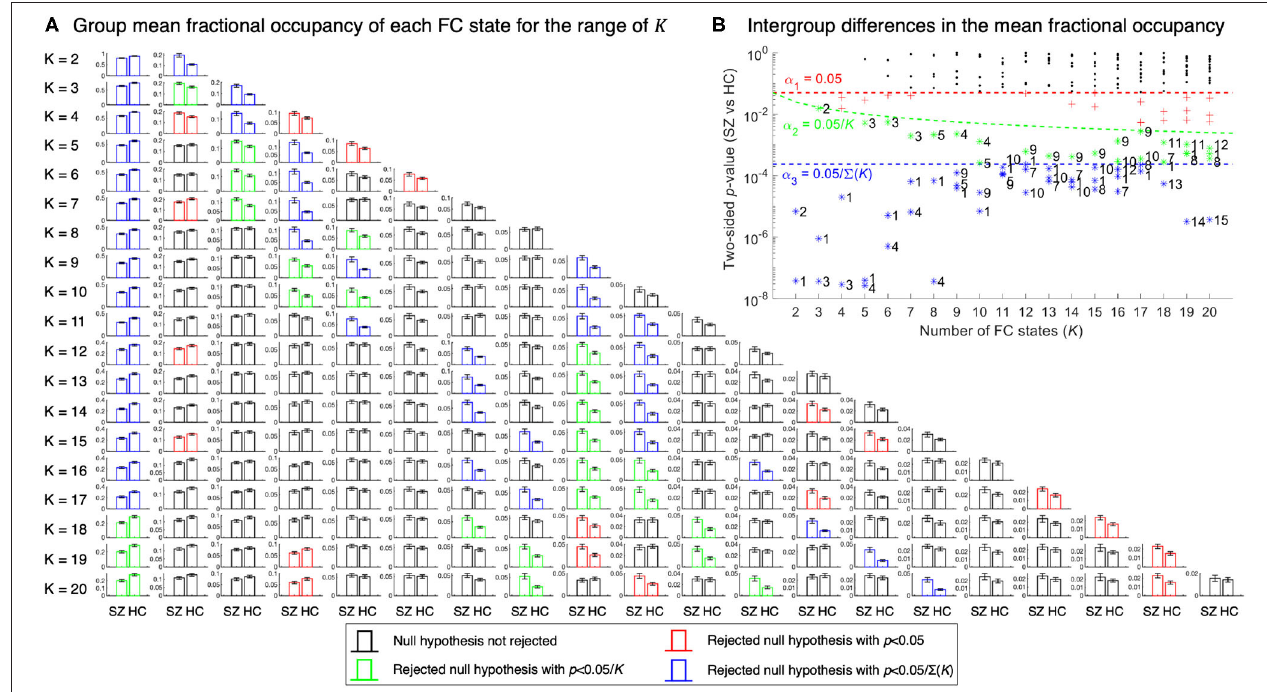
FIGURE 2 | Intergroup comparisons of the mean fractional occupancy of each FC state for each clustering solution. (A) Barplot of the estimated mean fractional occupancy with associated standard error of each FC state for each group. For each FC state, the color of the bars indicates whether the null hypothesis of no intergroup differences in the mean fractional occupancy was rejected (two-tailed tests). The standard error of each bar was calculated as the standard deviation of the sample data divided by the square root of the sample size. (B) Two-sided p -values obtained for the intergroup comparisons of the mean fractional occupancy of each FC state for each partition model. FC states (clusters) are ranked according to their probability of occurrence, where cluster 1 consists of the largest number of objects and cluster K consists of the least number of objects. The red, green and blue dotted lines correspond to a 0.05, 0.05 / K and 0.05 /